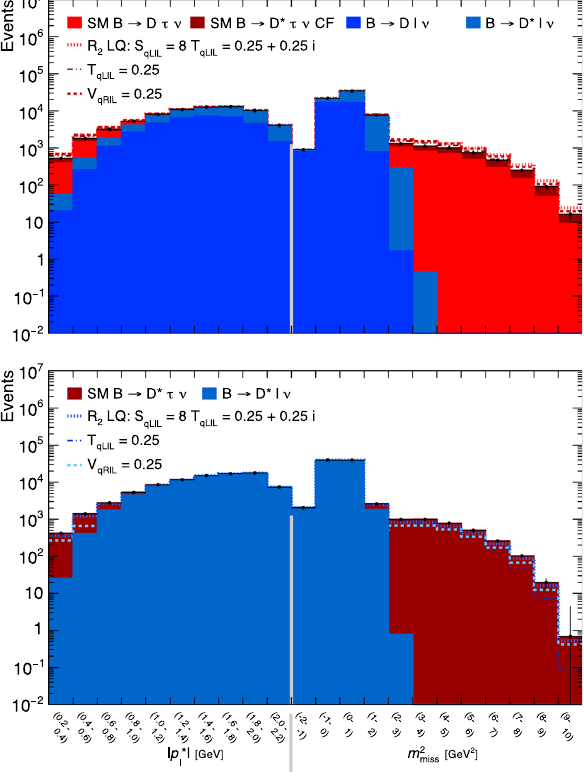
Fig. 2 The B → D τ ¯ ν (top) and B → D ∗ τ ¯ ν (bottom) distributions in | p ∗ | and m 2 in the Asimov data set. The number of events (cid:8) miss